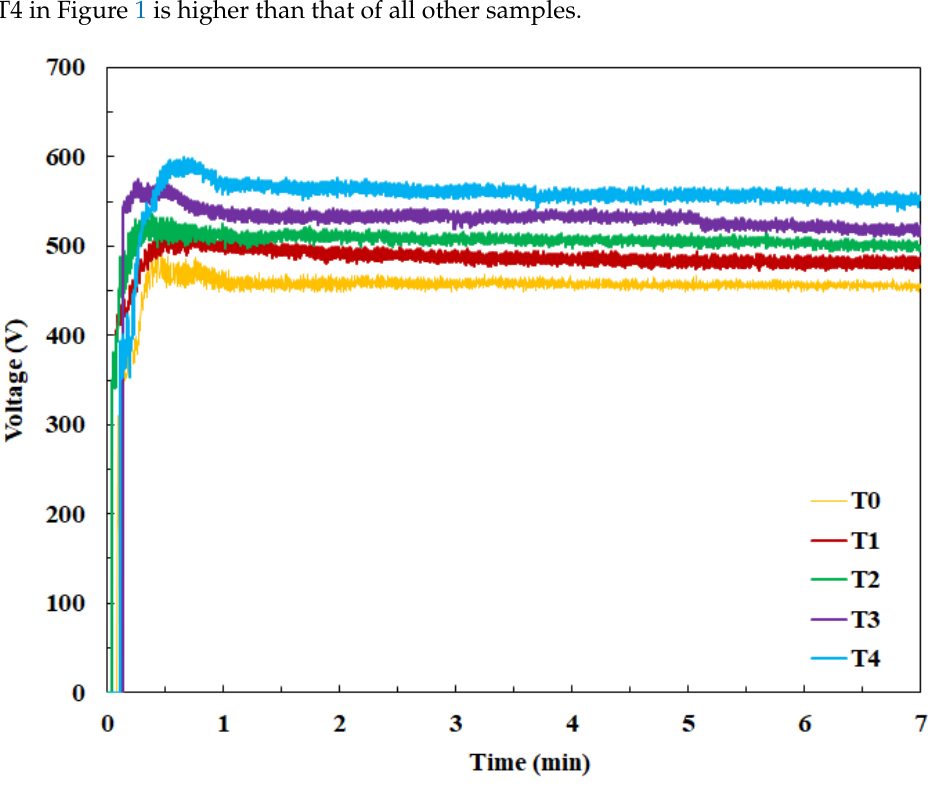
Figure 1. Voltage–time plots for PEO-coated specimens. Table 3. The results of the voltage–time diagram.